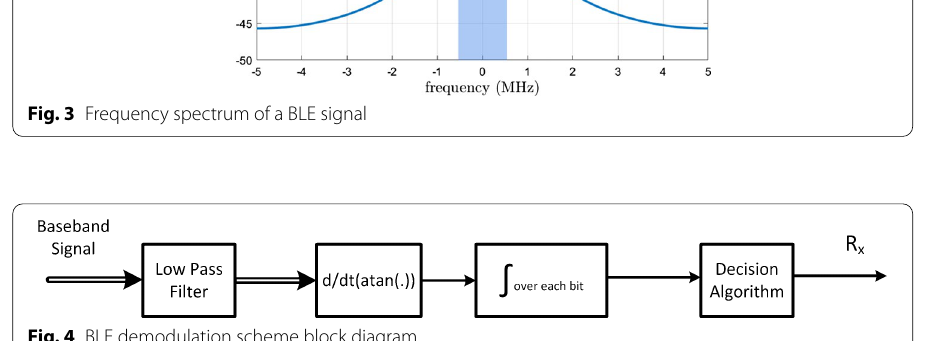
Fig. 4 BLE demodulation scheme block